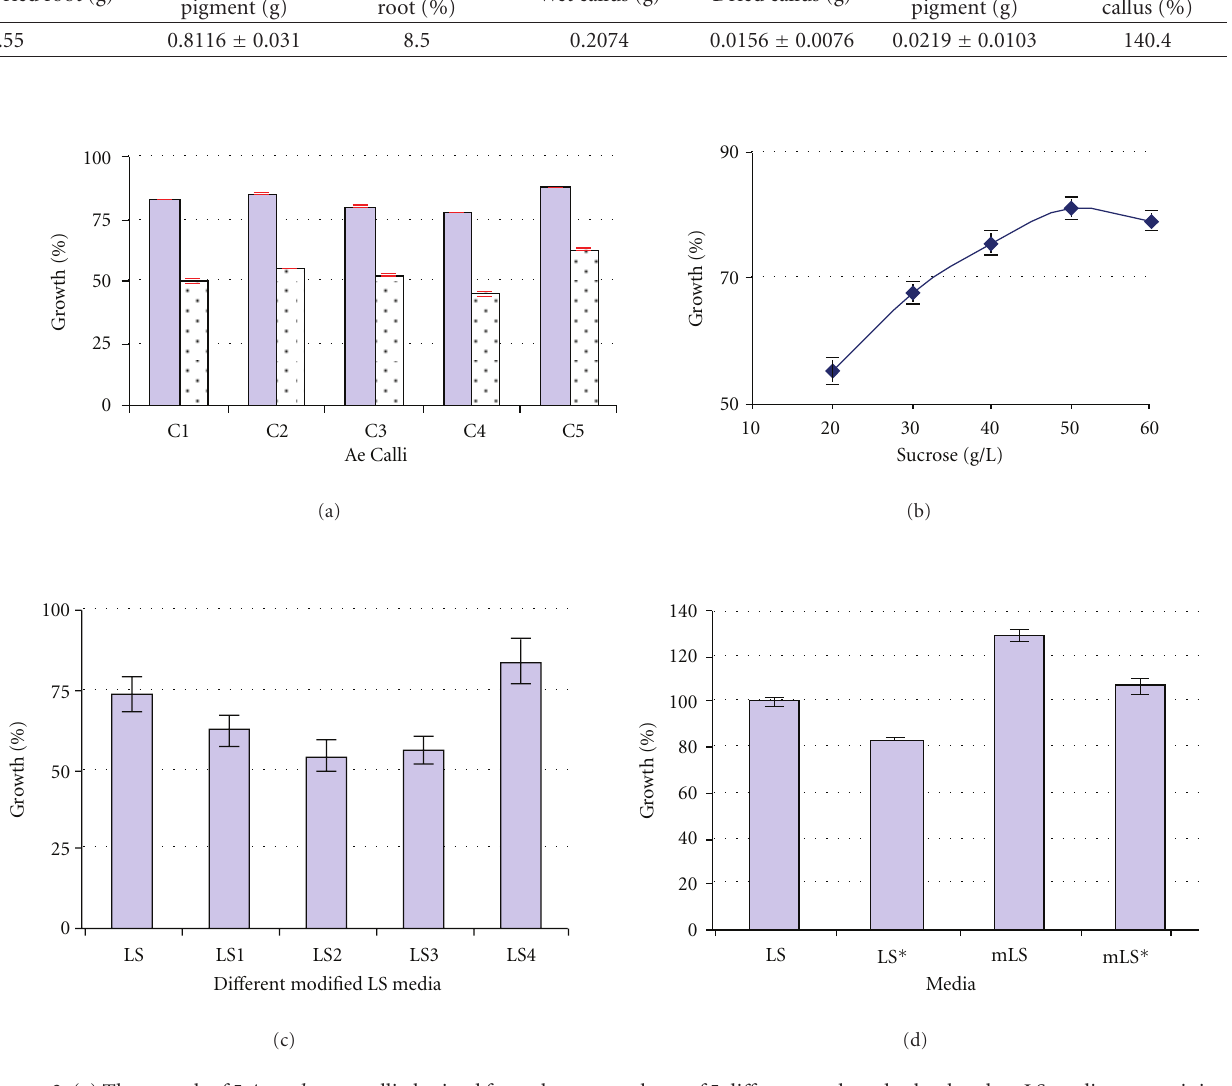
Figure 3: (a) The growth of 5 A. euchroma calli obtained from the root explants of 5 di ff erent seeds and subculturd on LS medium containing 2,4-D (10 − 6 M), kinetin (10 − 5 M), and sucrose (30g/L) in the dark (filled bars) and the light (spotted bars). The growth of the A. euchroma callus subculturd on: (b) LS medium containing 2,4-D (10 − 6 M), kinetin (10 − 5 M), and di ff erent amounts of sucrose in the dark, (c) modified LS media [LS (normal LS), LS1 ([NH 4 NO 3 ] = 0, [KNO 3 ] = 1900 mg/L), LS2 ([NH 4 NO 3 ] = 0, [KNO 3 ] = 950mg/L), LS3 ([NH 4 NO 3 ] = 16.5, [KNO 3 ] = 1900 mg/L), LS4 ([NH 4 NO 3 ] = 0, [KNO 3 ] = 2850 mg/L)] containing 2,4-D (10 − 6 M), kinetin (10 − 5 M) in the dark, (d) LS, mLS and vitamins-free media (LS ∗ and mLS ∗ ). Except for the experiments of 3b, all the media applied in the other experiments contained 30 g/L of